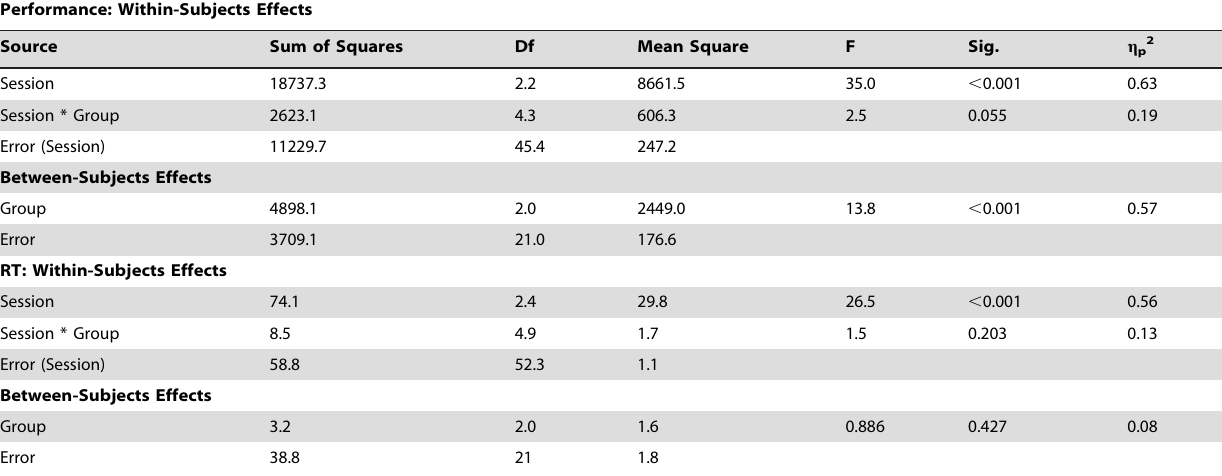
Table 2. Two-way ANOVA results for performance (percent of targets reached by each participant in a session) and reaction time